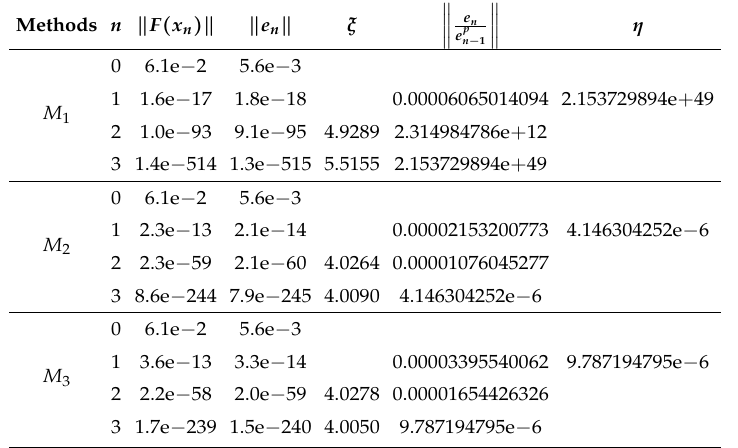
Table 5. Convergence behavior of different cases on Example 1.